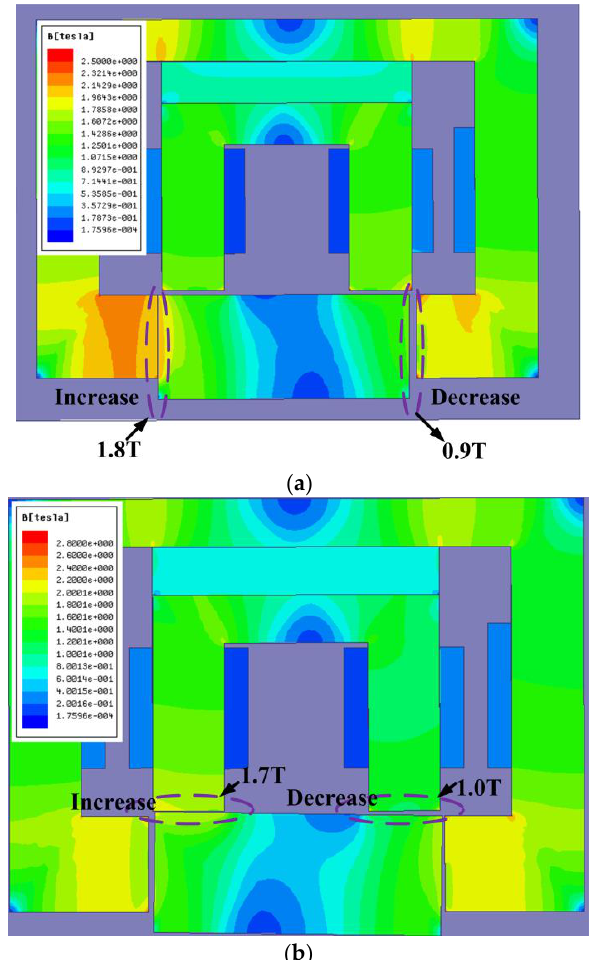
Figure 10. Flux density distribution when the rotor deviates away from the equilibrium position. ( a ) Flux density distribution when the rotor offsets in the axial direction; ( b ) flux density distribution when the rotor twists in the radial direction.